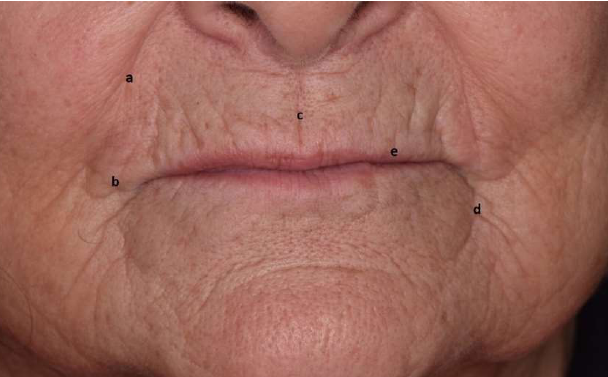
Figure 2. “Scope of action” of the dental practitioner. The lower third of the face: ( a ) nasolabial fold, ( b ) labial commissure, ( c ) philtrum, ( d ) bitterness fold, and ( e ) vermilion zone.